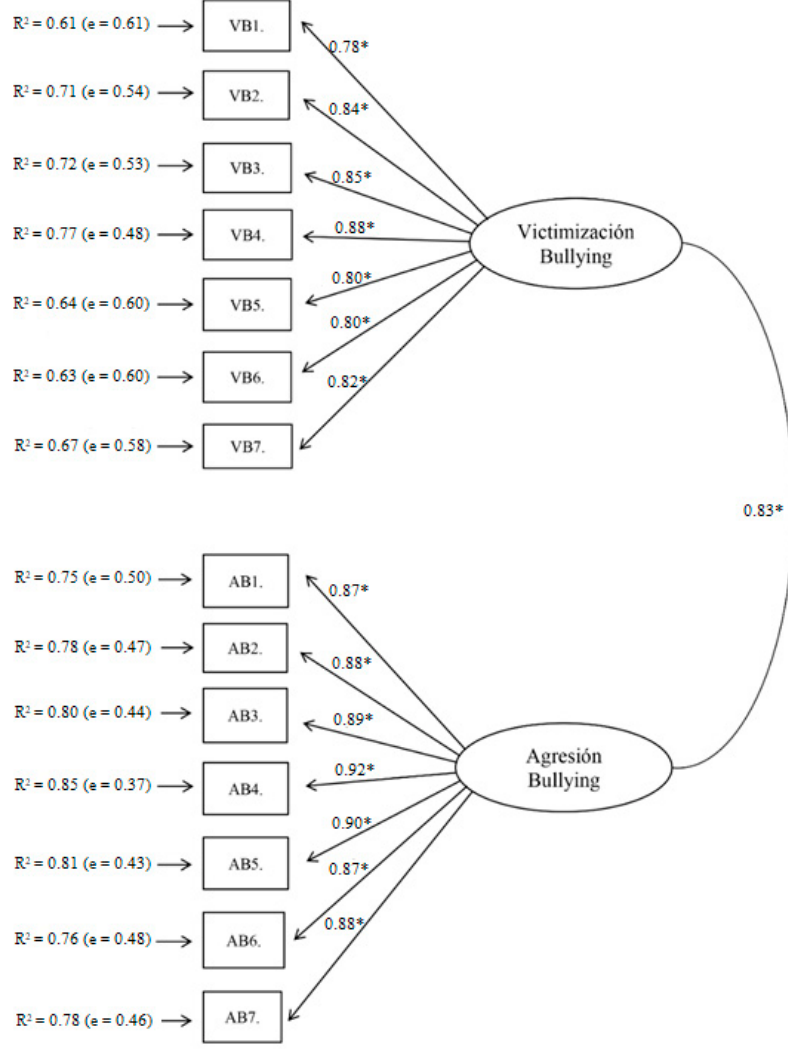
Figure 1. Confirmatory factorial analysis (CFA) of the adapted EBIPQ for Ecuador (* p < 0.05).